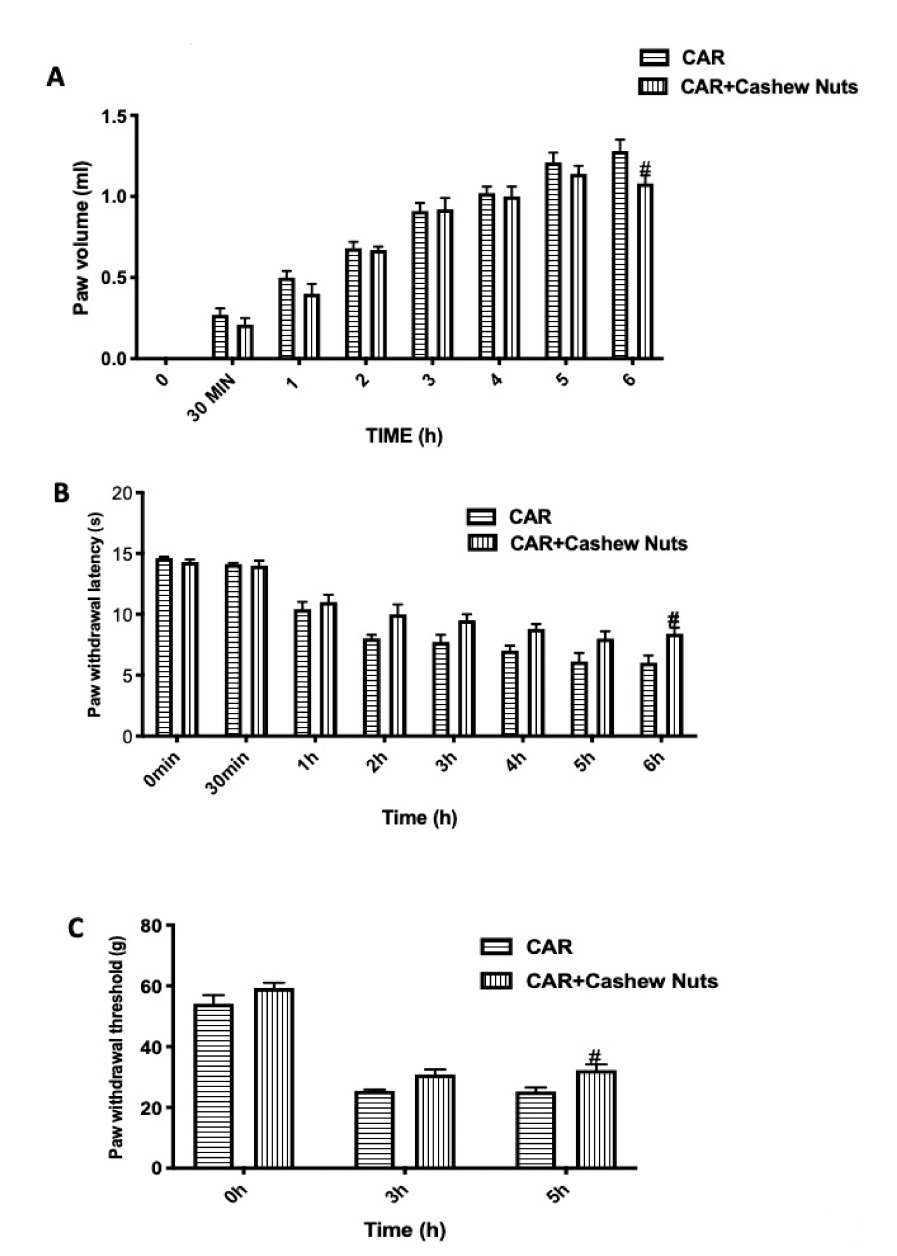
Figure 1. Evaluation of the e ff ects of cashew nuts on carrageenan (CAR)-induced inflammation and pain. Paw edema was induced by subplantar injection of CAR. Paw volume was measured before the subplantar injection and hourly to 6 h. The edema volume is the di ff erence in the paw volume at each time-point and the basal paw volume. Hyperalgesia and mechanical allodynia were assessed at the time points indicated with plantar and Von Frey tests. Cashew nuts administration shows significant improvement in the treatment of inflammation and pain. See materials and methods for further